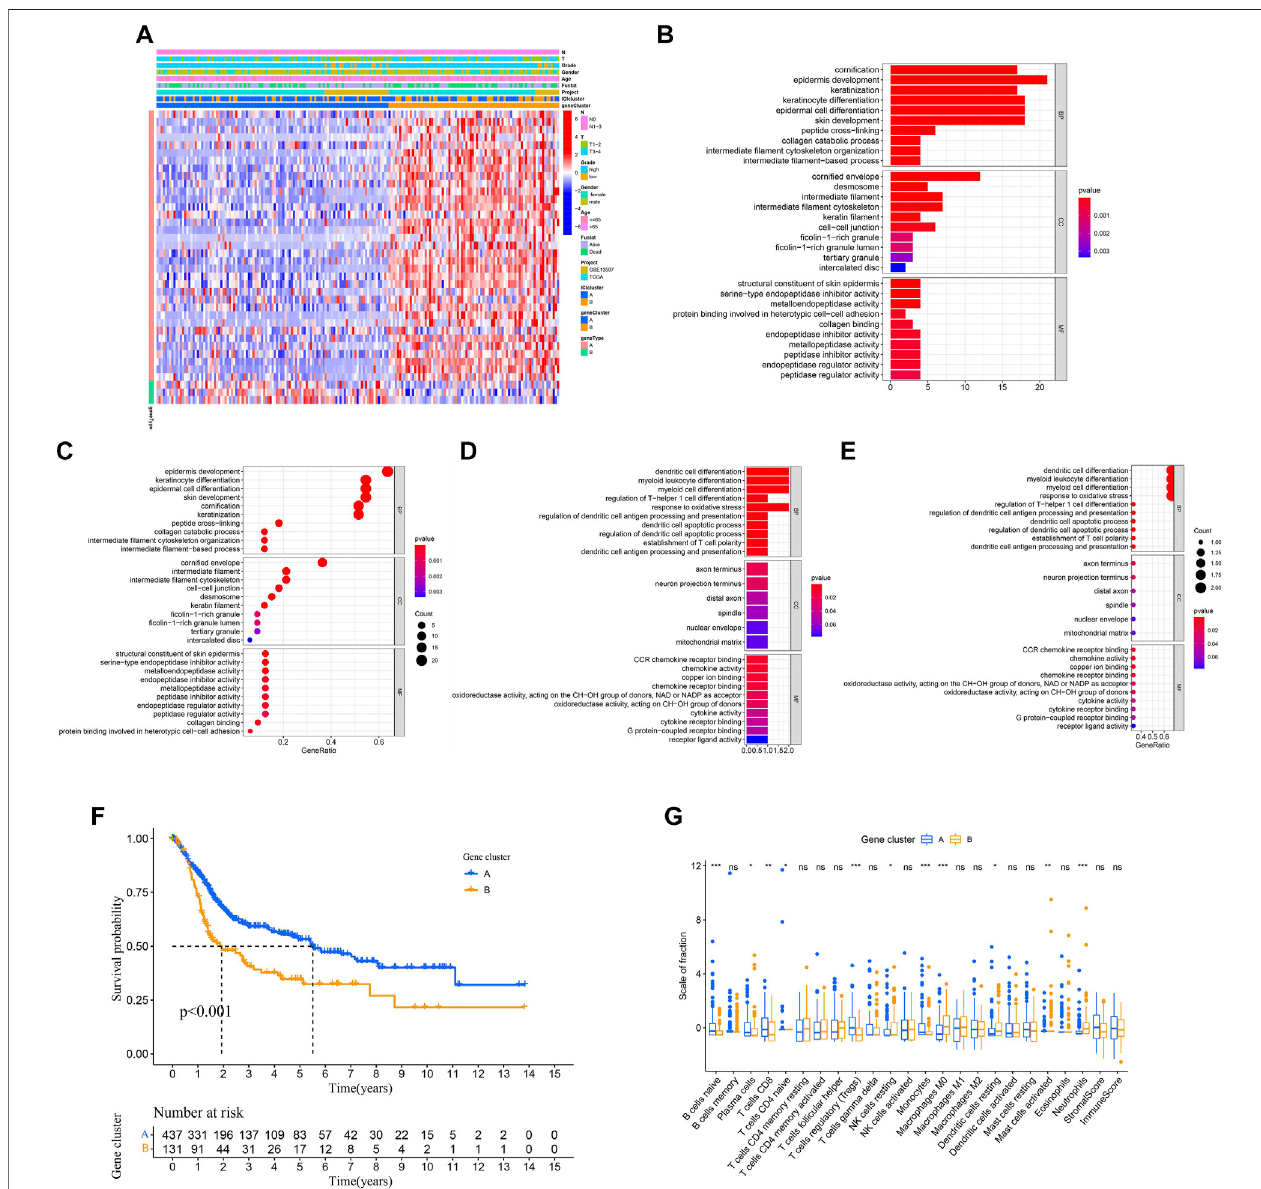
FIGURE 5 | Identi fi cation of the subtype of the immune gene. (A) Description of the transcriptomic pro fi le of DEGs identi fi ed across the genomic clusters. (B – E) Functional and pathway enrichment analyses (Gene Ontology-Biological process) of ICI gene signatures A and B: ICI signature genes A (B – C) and B (D – E) . (F) Two independent geneclustershadasigni fi cantdifference intheoverallsurvivalrate(log-ranktest, p < 0.001). (G) Theproportionoftumor-in fi ltratingimmunecellsinthetwo gene clusters. We also depicted the immune score and stromal score of two gene clusters. * p < 0.05; ** p < 0.01; *** p < 0.001.